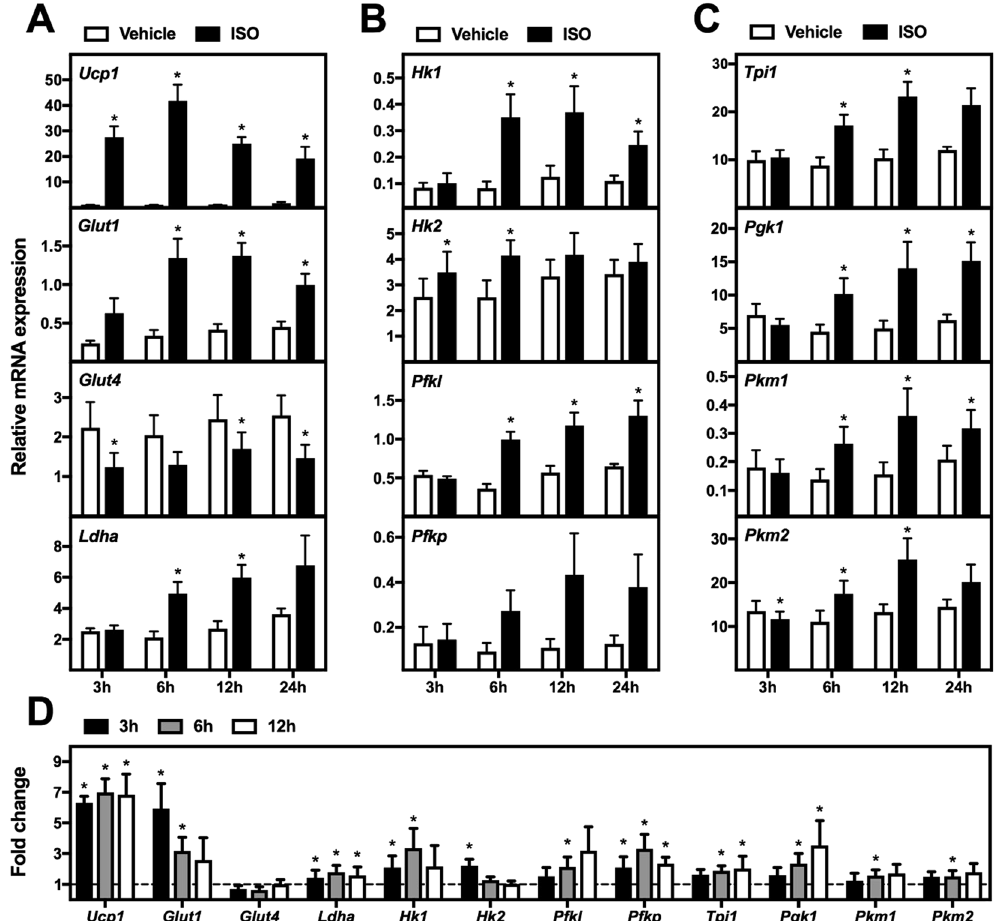
Figure 2. Expression levels of genes associated with glycolysis in brown adipocytes after β -adrenergic stimulation in vitro . ( A–C ) Mature brown adipocytes (WT-1) were treated with vehicle (white bars) or 0.1 μ M isoproterenol (ISO, black bars) for 3, 6, 12 or 24 h. Total RNA was harvested and analyzed by RT-qPCR (n = 4). Relative gene expression was measured for: ( A ) Ucp1 , Glut1 , Glut4 and Ldha ; ( B ) Hk1 , Hk2 , Pfkl and Pfkp ; ( C ) Tpi1 , Pgk1 , Pkm1 and Pkm2 . ( D ) Mature primary brown adipocytes were treated with vehicle or 0.1 μ M isoproterenol for 3 h (black bars), 6 h (grey bars) or 12 h (white bars). Relative gene expression was measured and presented as fold change relative to the corresponding vehicle-treated samples (n = 4). mRNA expression levels were normalized to Tbp . Data represent mean of means + SEM. * p < 0.05 versus vehicle